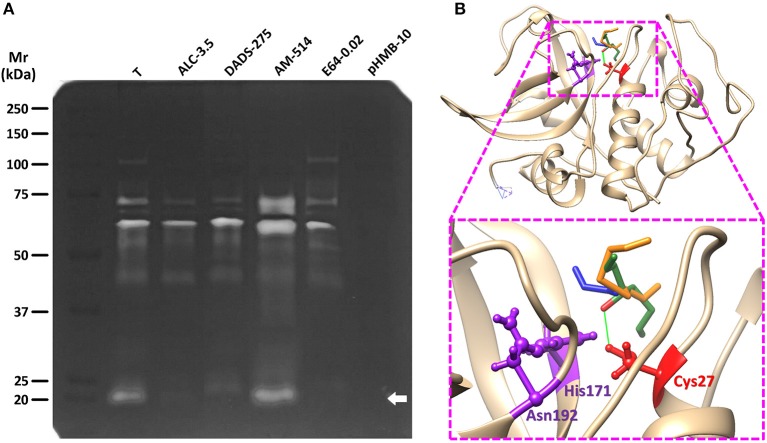
Effect of representative TACs on the proteolytic activity of G. duodenalis trophozoite lysates and docking with giardipain-1. (A) Trophozoite lysates (50 μg) were electrophoretically separated in 10% acrylamide-0.2% gelatin gels and cysteine protease activities were developed and detected by DTT treatment at pH 5.5 and Coomassie blue staining. Lanes in which extracts were pre-incubated with the three TACs tested (ALC, DADS, and AM) are indicated along with the concentration values (mM) used in each case. The thiol-active inhibitor pHMB (10 mM) and the cathepsin B-specific inhibitor E64 (20 μM) were included as controls. Molecular weight standards and its relative mobility (Mr) are as indicated at the left. The arrow points to the band containing the cysteine protease giardipain-1. (B) The most favored docking position of representative TACs (in stick conformation, green: ALC, orange: DADS, blue: AM) at the proximity of the catalytic Cys27 of giardipain-1 in which the Oxygen atom of ALC is predicted to form a bridge with the Hydrogen G1 of Cys27 at a distance of 2.425 Å (green line). The three catalytic residues (Cys26, His171, and Asn192) are represented in ball-and-stick conformation.